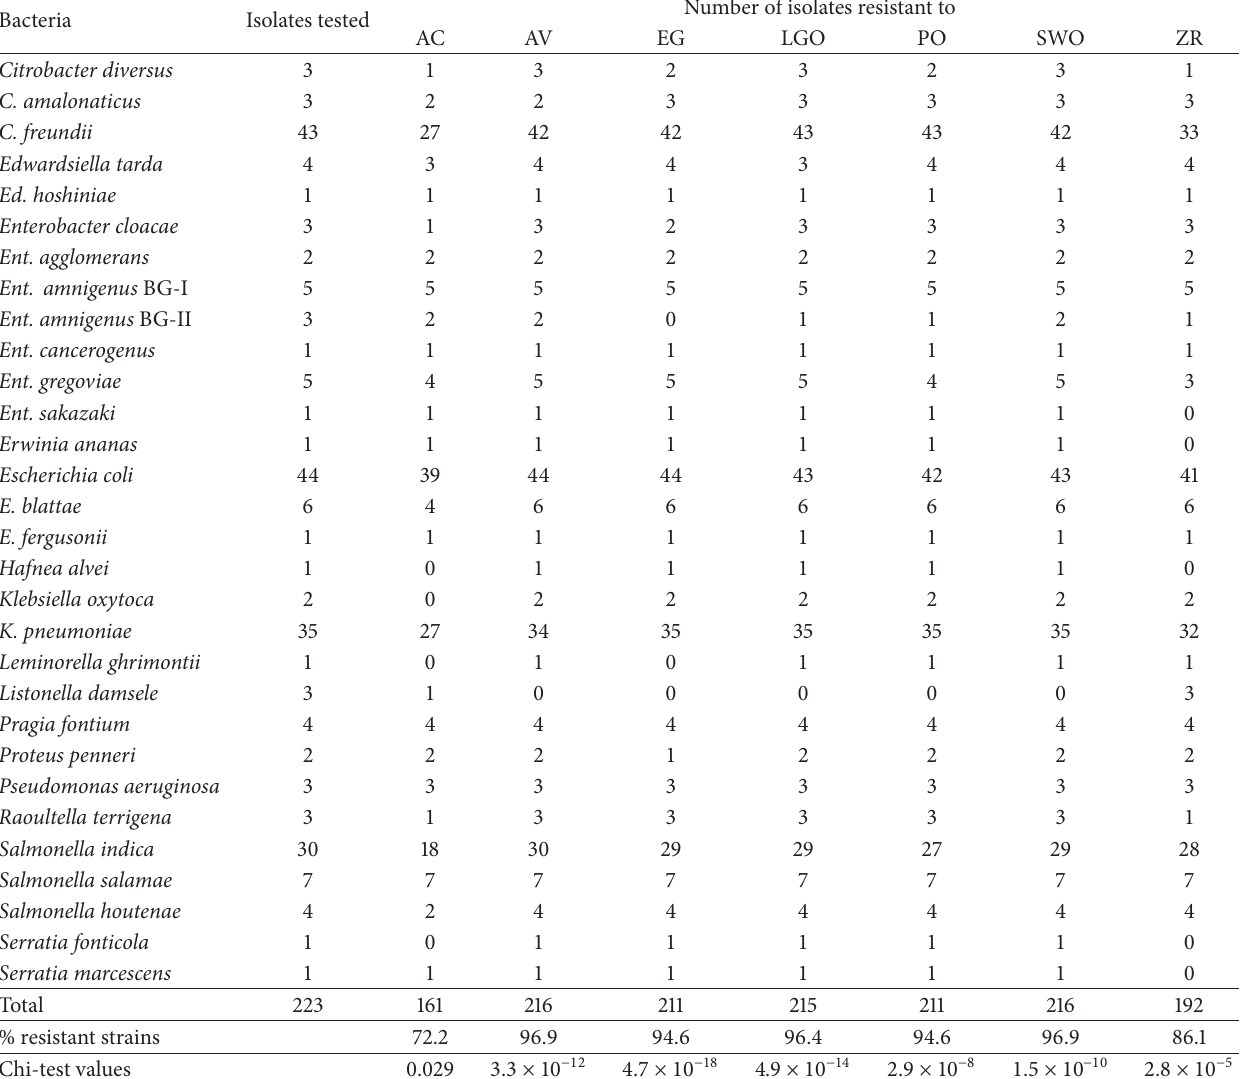
Table 3: Antimicrobial herbal-drug resistance of bacteria isolated from faecal droppings of geckos.